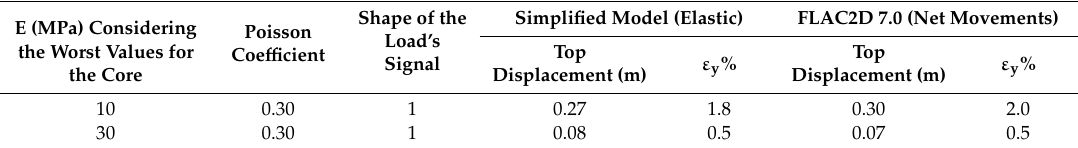
Table 4. Results obtained with the simplified model and with FLAC2D 7.0 code, comparison without considering transverse deformation of the soil.